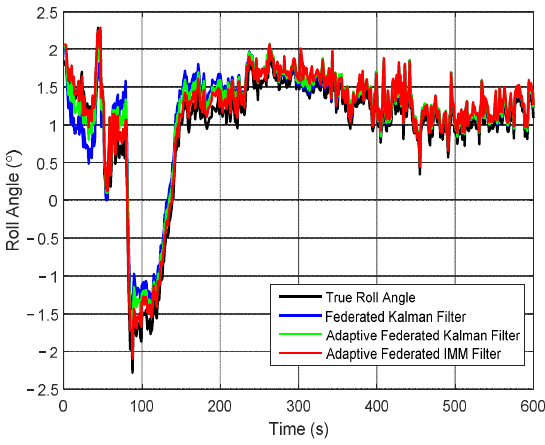
Sensors 2020 , 20 , x FOR PEER REVIEW Figure 11. The estimation curves of roll angle. Figure 11. The estimation curves of roll angle.